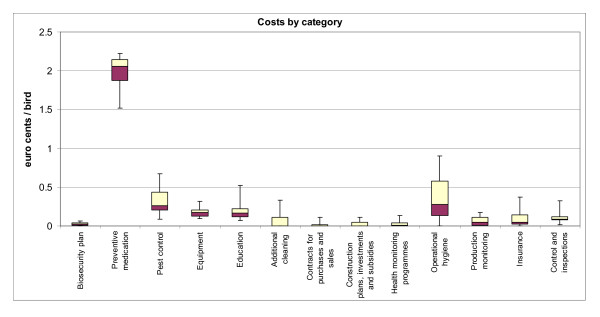
Median on-farm biosecurity costs for broiler producers by category and per bird, together with the 25th and 75th (boxes) and the 5th and 95th (whiskers) percentiles.